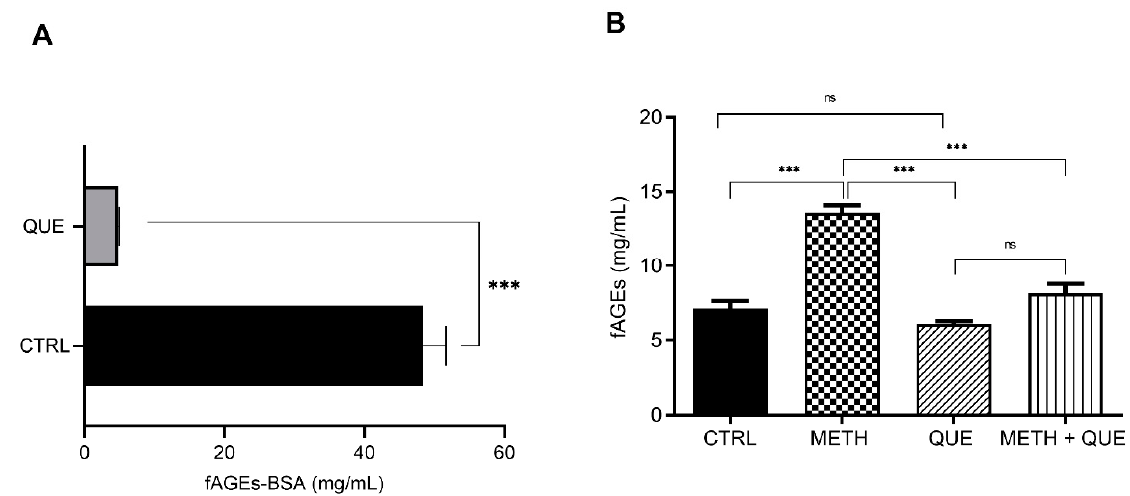
Figure 4. METH induced fAGEs-BSA formation in vitro is inhibited by the antioxidant QUE. ( A ) fAGEs-BSA hydrothermal synthesis with 50 mg/mL BSA, 0.5 M glucose and Na 2 HPO 4 buffer alone (CTRL) or with 10 mM quercetin (QUE). All samples were prepared in triplicates and all replicas were measured three times ( n = 9). Data are presented as mean ± SEM. Significant values: ***: p < 0.001. ( B ) fAGEs concertation in wt male whole body extracts prepared using PBT protocol: (CTRL) mock treated, (METH) fed 0.5 mg/mL METH alone or 3.2 mM QUE alone (QUE) or in combination (METH + QUE) for 48 h ( n = 5 flies for each condition, in triplicates). Significant values: ***: p < 0.001 and non-significant (ns).